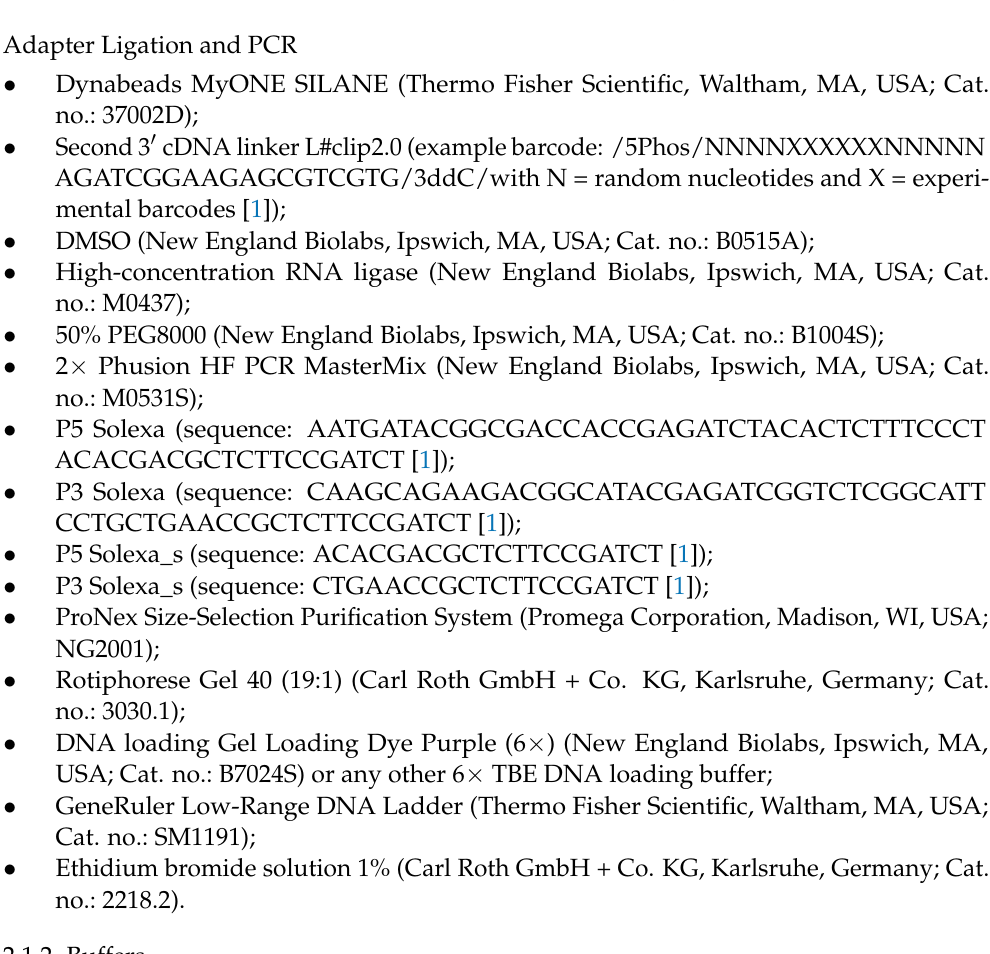
Table 7. RNA-Primer Mix for Reverse